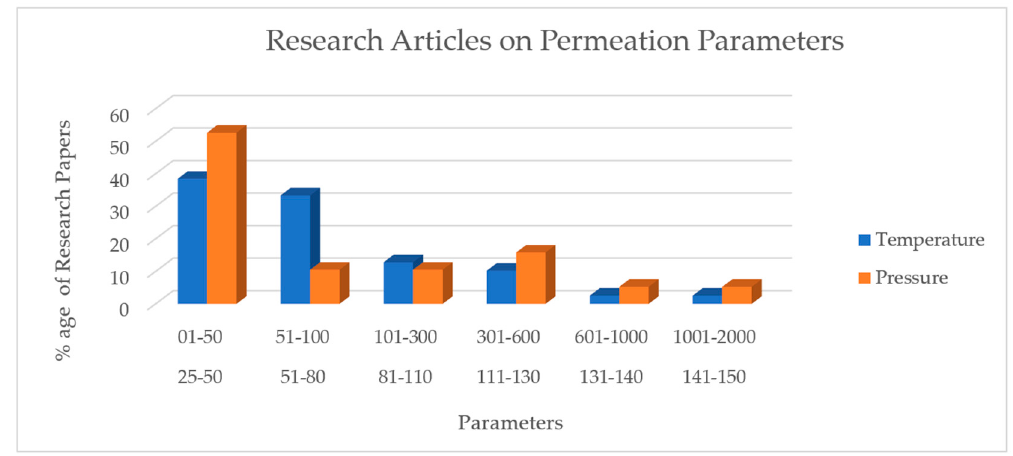
Figure 6. Process Parameters in Permeation Experiment.